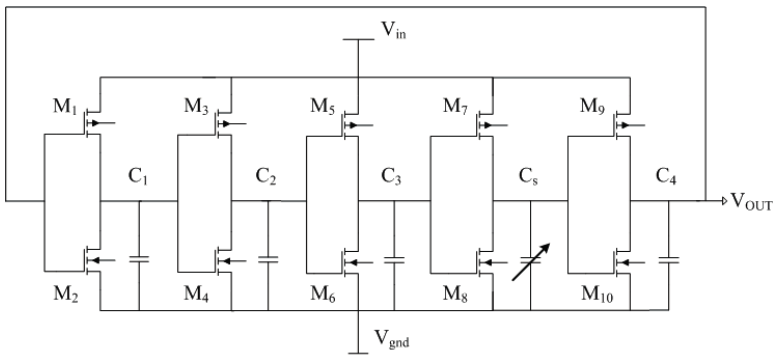
Figure 2. Readout circuit for the ethanol